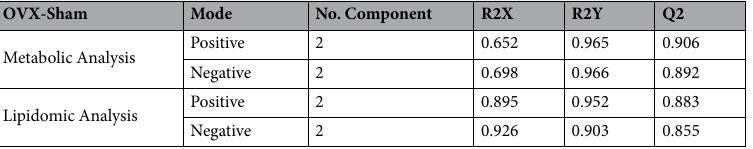
Table 1. Summary of the parameters for assessing quality of partial least square discriminate analysis (PLS-DA)